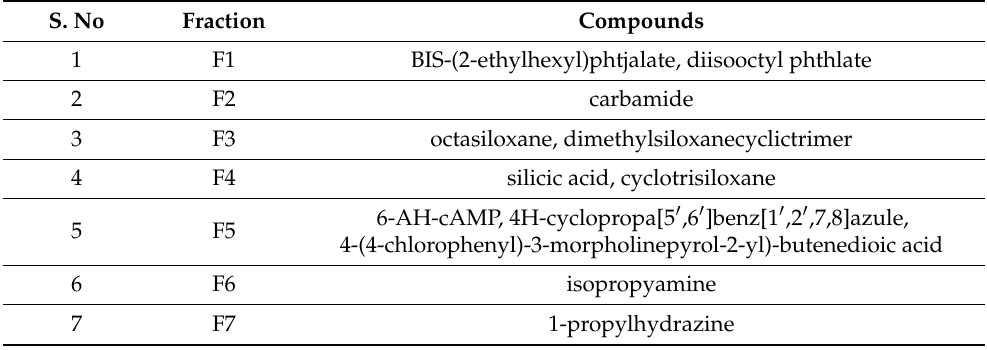
Table 3. List of the identified compounds in Cydonia oblonga bark fractions (F1-F7) determined through GC-MS